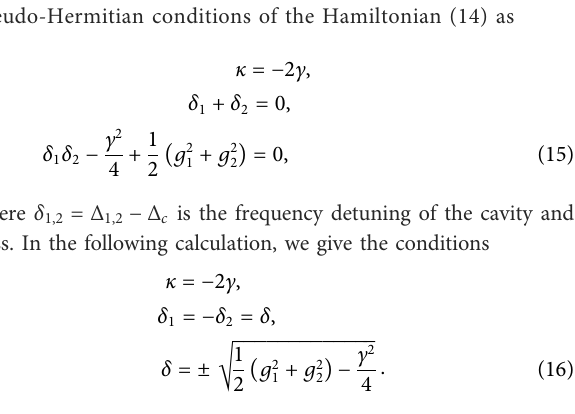
FIGURE 9 (A) Quantum phase of the discriminant in Eq. 19 under the pseudo-Hermitian conditions in Eq. 16 as a function of coupling strengths g and g 2 / γ . (B) The yellow dots represent the ranges of 0 < g 1 / γ ≤ 2 and 0 < g 2 / γ ≤ 2 are plotted to predict EP3. (C, D) Real and imaginary parts of the eigenvalues Ω 0 (see the black lines) and Ω ± (see the red and blue lines) versus the same coupling strength g / γ in the conditions of Eq.